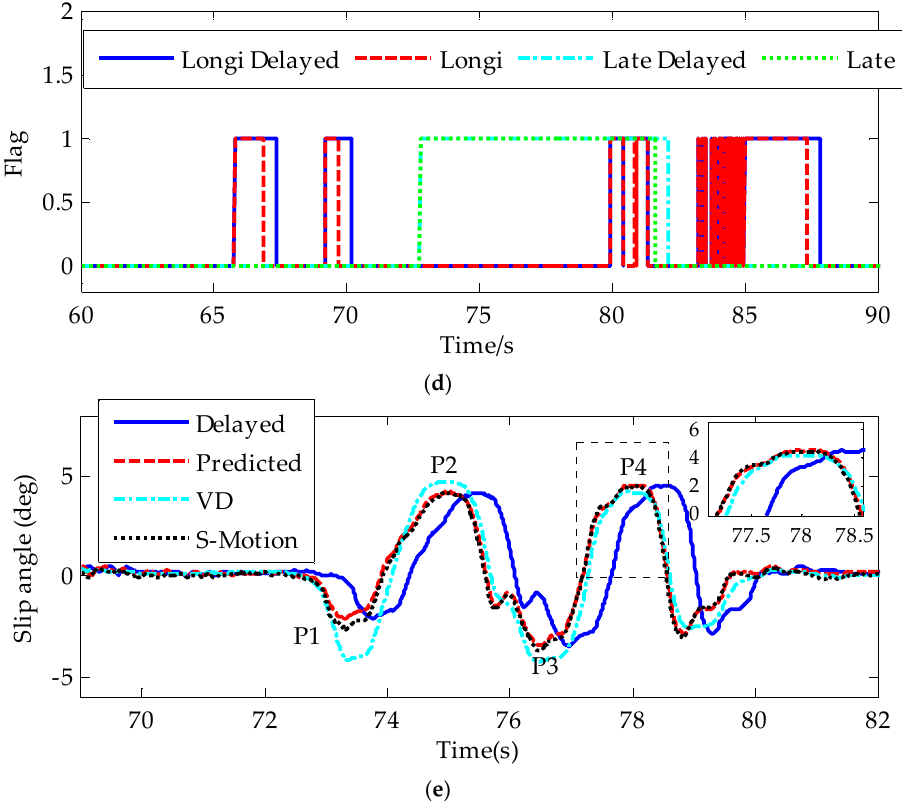
Figure 11. Test results in slalom maneuver: ( a ) trajectory; ( b ) roll angle; ( c ) pitch angle; ( d ) flag; ( e ) slip angle.